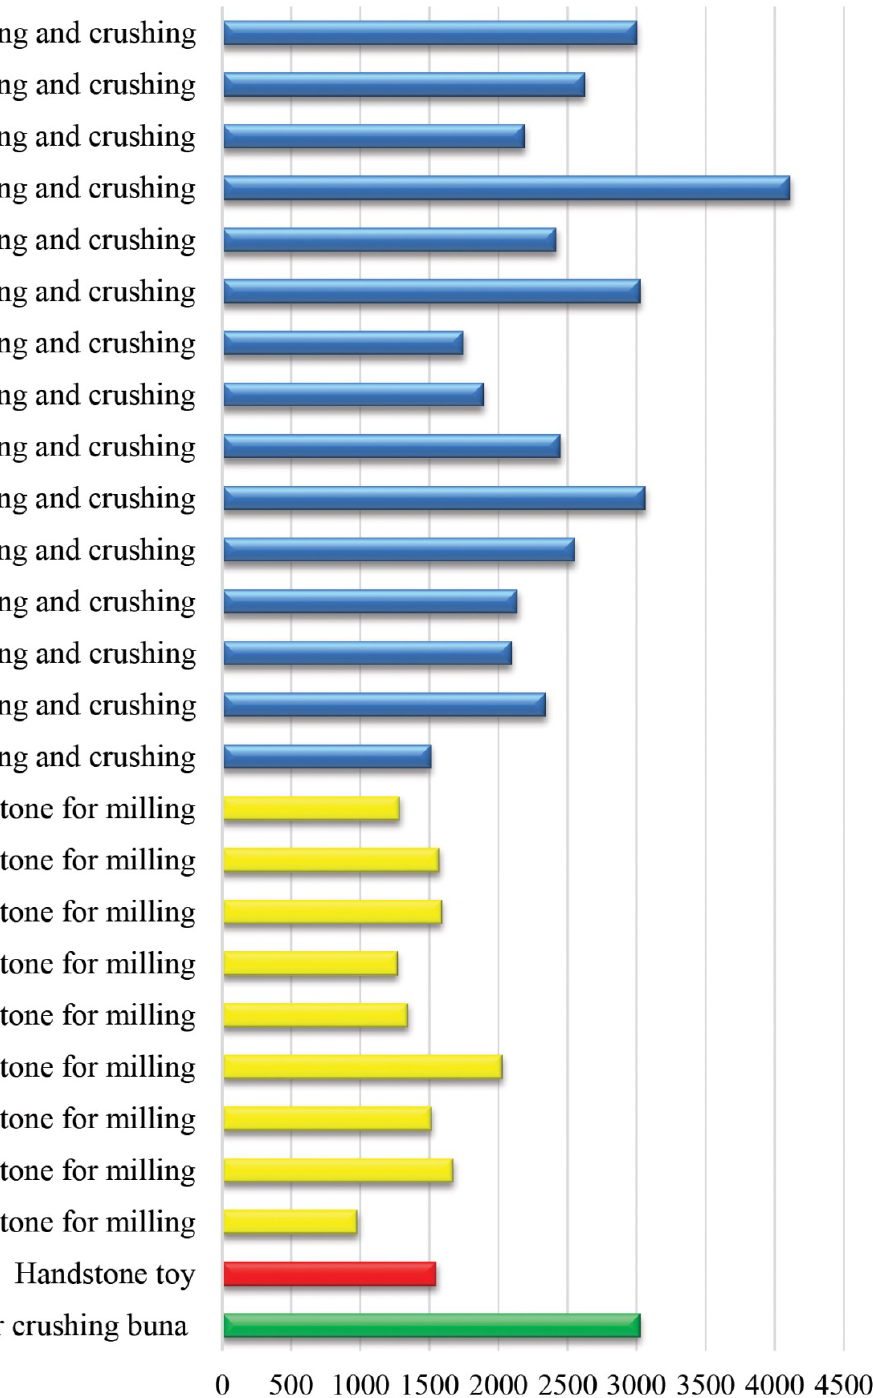
Figure 10. Volumetric characteristics of